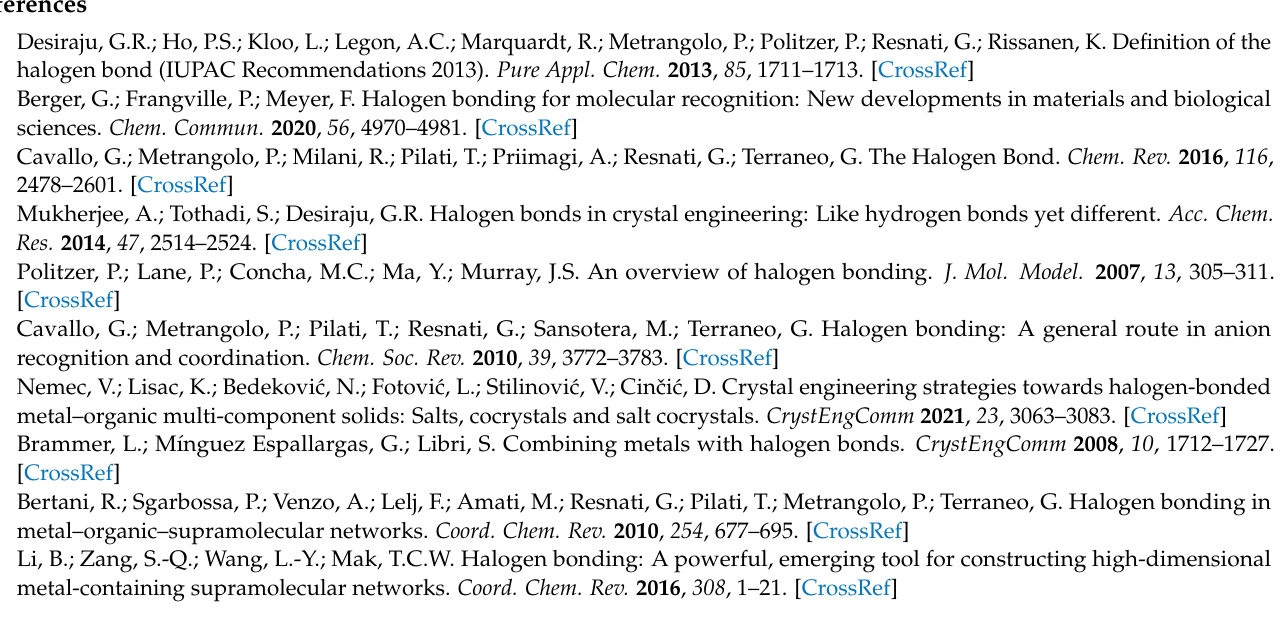
Formation of 2D polymer networks in adducts 1 · tbe (top) and 2 · tbe (bottom); Figure S3: IR-spectra of complex trans -[PtBr 2 (NCN(CH 2 ) 5 ) 2 ]: 2944 (w), 2852 (w), ν (C–H); 2291 (s), ν (C ≡ N); 1170 (w), 1107 (w), ν (C–N); 467 (m), ν (Pt–N); Figure S4: Mass spectrum of complex trans -[PtBr 2 (NCN(CH 2 ) 5 ) 2 ]; Figure S5: 1 H NMR spectrum of complex trans -[PtBr 2 (NCN(CH 2 ) 5 ) 2 ]; Figure S6: 13 C{ 1 H} NMR spectrum of complex trans -[PtBr 2 (NCN(CH 2 ) 5 ) 2 ]; Figure S7: 195 Pt NMR spectrum of complex trans - [PtBr 2 (NCN(CH 2 ) 5 ) 2 ]; Figure S8: Comparison of PXRD (red line) and XRD (blue line) complex trans -[PtBr 2 (NCN(CH 2 ) 5 ) 2 ]. The phases coincide, the difference is due to different experimental conditions (for PXRD—RT, for XRD—100 K). Figure S9: Structure of cluster 1 · tbe (halogen bonding); Figure S10: Structure of cluster 1 · tbe (hydrogen bonding); Figure S11: Structure of cluster 2 · tbe (halogen bonding). Table S1: Crystal data and structure refinement for 1 · tbe , 2 and 2 · tbe at 100 K; Table S2: Values of the Wiberg indices (WBI), Lagrangian kinetic energy G(r), potential energy density V(r) and energy density H(r) (Hartree) at the bond critical points (3, − 1), corresponding to different noncovalent interactions in 1 · tbe